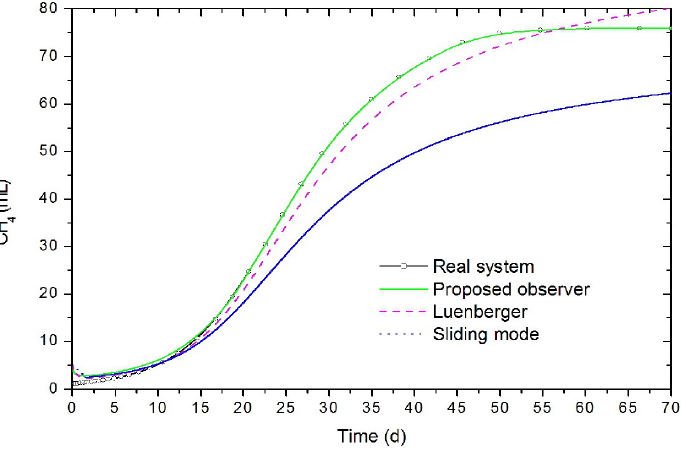
Figure 5. Simulation and comparison of the continuous-time observers, proposed observer vs. real system: Dynamics of the CH 4